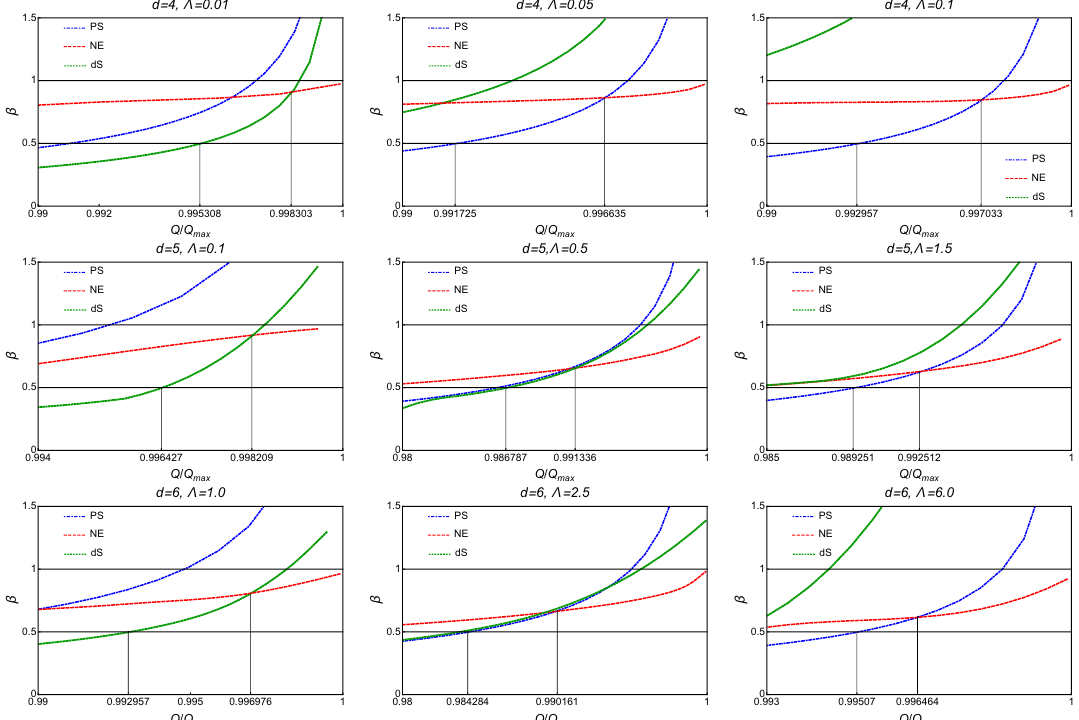
Figure 3 . The variation of (cid:12) , related to the imaginary part of the quasi-normal mode frequency, with ( Q=Q max ) has been presented for di(cid:11)erent spacetime dimension d and di(cid:11)erent choices of the cosmological constant (cid:3). The plots for (cid:12) (cid:17) (cid:0) (Im !=(cid:20) (cid:0) ) explicitly demonstrate that as the space- time dimension increases, the value of ( Q=Q max ), where the quasi-normal modes cross (cid:12) = (1 = 2), becomes smaller. Thus the parameter space associated with violation of strong cosmic censorship conjecture becomes larger. Note that ultimately, the near extremal modes (red dashed line) starts dominating over the photon sphere modes (blue dashed line) or the de Sitter modes (green dashed line) before reaching (cid:12) = 1. Each rows of these plots are for a (cid:12)xed spacetime dimension but for di(cid:11)erent choices of the cosmological constant. The (cid:12)rst black vertical line corresponds to the value of ( Q=Q max ) where strong cosmic censorship conjecture is violated and the second vertical line presents the location of ( Q=Q max ), where near extremal modes (drawn for ‘ = 0) starts to dominate over and above the photon sphere modes (drawn for ‘ =